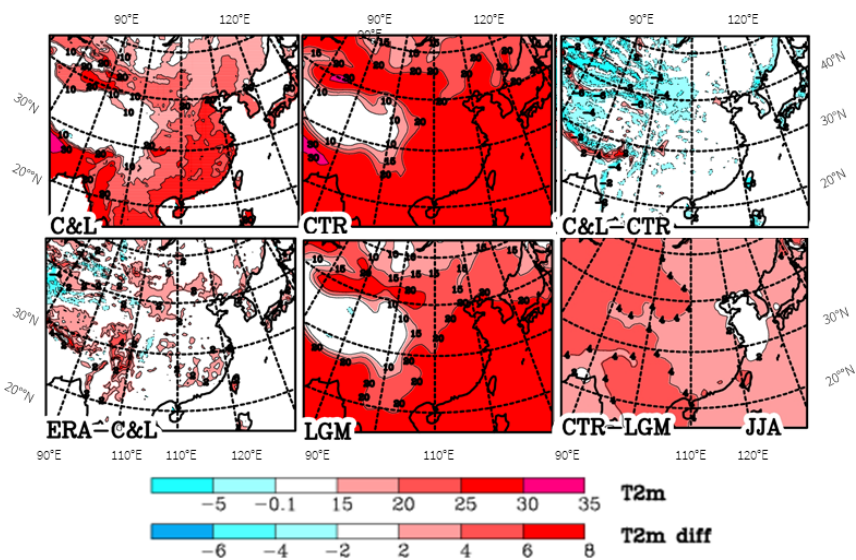
Figure 3. Climatological mean distribution of temperature (T2m; ◦ C) over eastern Asia for June, July and August (JJA). Values by Leemans and Cramer (1991) (C&L), the ECMWF reanalysis (ERA-Interim) and model simulations (CTR and LGM), as well as some differences between